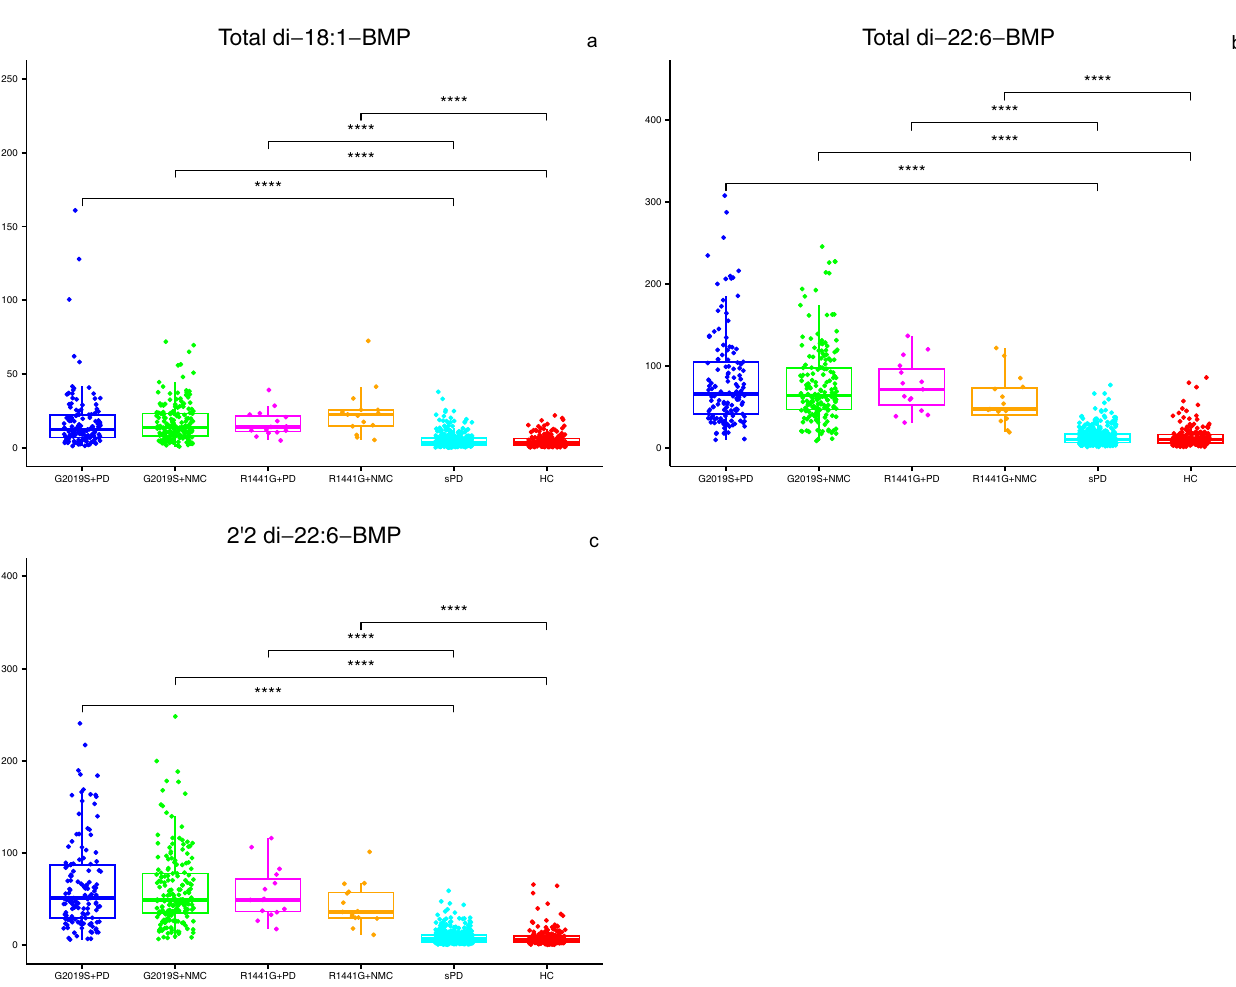
Fig. 1 Levels of three BMP isoforms in LRRK2 G2019S + and R1441G + individuals compared to HC and sPD. a – c Plots show baseline concentrations of each speci fi c BMP isoform in the six groups indicated on the X -axis. Box-and-whisker plots with scatter plots superimposed are shown with each fi lled circle representing observed data. The bottom and top edges of the box correspond to the 75th and 25th percentiles, respectively. The horizontal line within the box indicates the median. The whiskers indicate the range of values within 1.5 times the interquartile range. A Rank-based linear model with adjustment for age and sex was used for pairwise comparisons. The signi fi cance level for pairwise comparisons is p value <0.0125 (after Bonferroni correction). **** p value